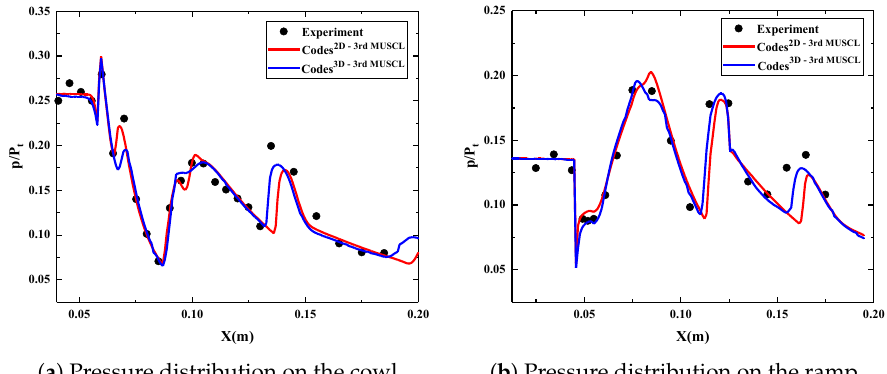
Figure 13. Comparison of 2D/3D simulation